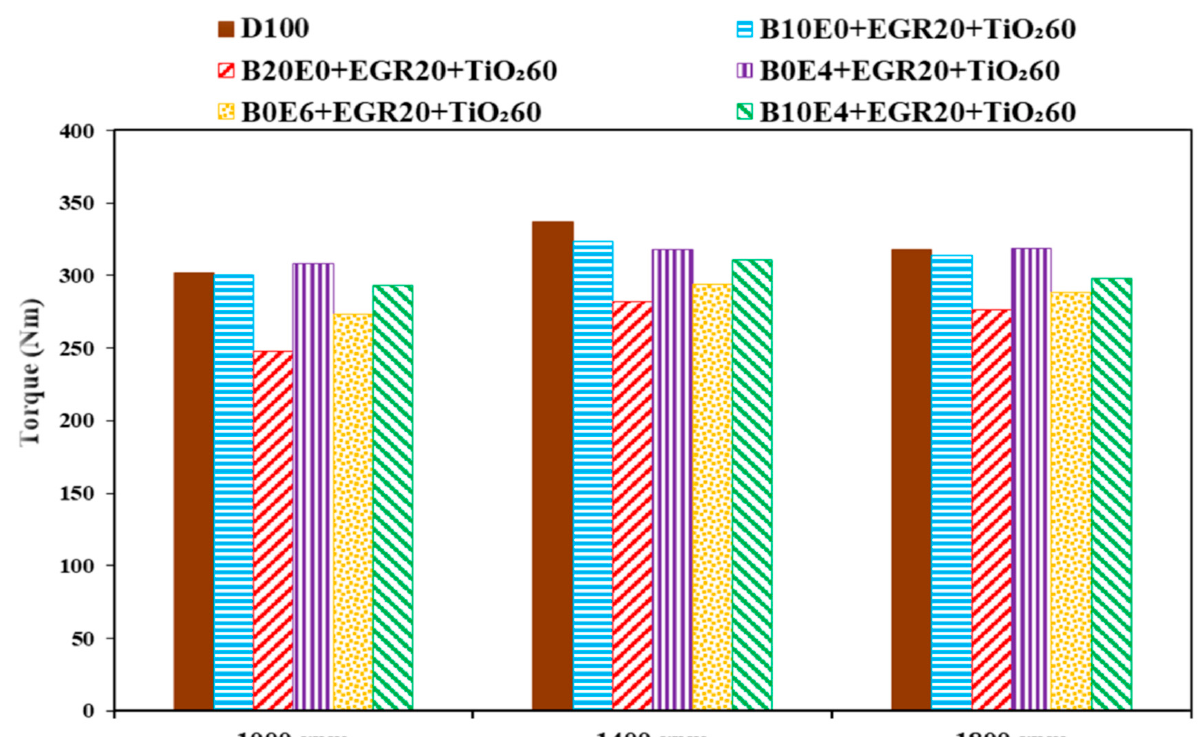
Figure 5. Variation of torque for diesel/ethanol/biodiesel blends at TiO 2 = 40 ppm, EGR = 20%, and various engine speeds.